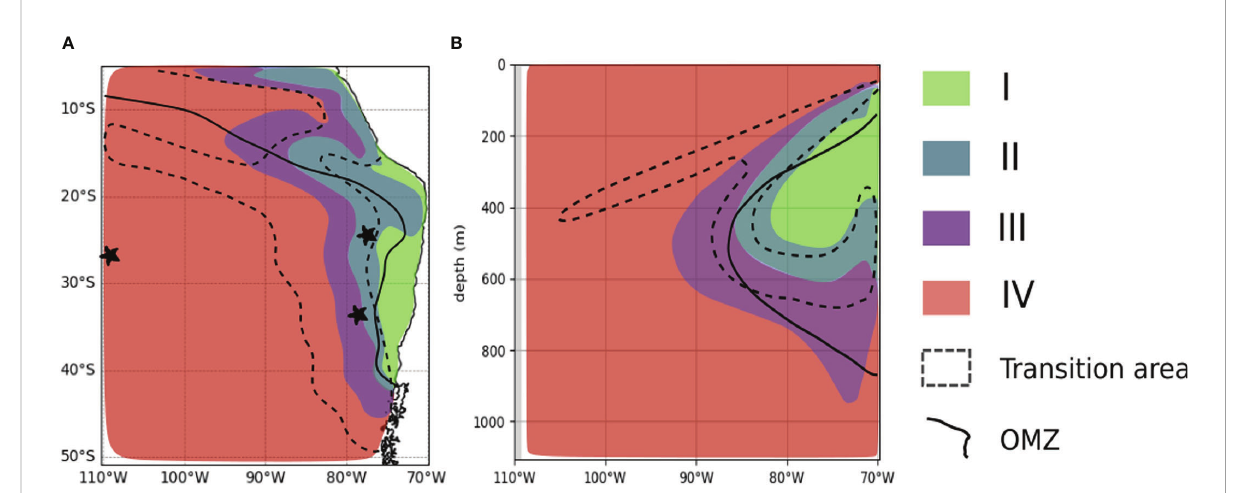
FIGURE 9 Areas of climate change exposure. Areas of climate exposure in the SEP at 200m (A) and the vertical representation at 26°S (B) derived from the horizontal velocities. We de fi ned areas of climate exposure based on the components of the climate velocities of Ф using the model species. Areas I and II designate “ safe ” areas based on positive trends in Ф . Areas III and IV designate “ at risk ” areas based on negative trends in Ф . Areas II and III are areas of slow velocities (|CV|< 1 km.yr -1 ) where the spatial gradient controls the magnitude of CV F over the temporal trends. The transition area (dashed envelope) is the area most subjected to uncertainty in the sign and magnitude of the velocity due to high uncertainty in the sign of oxygen trends and the effect of E 0 . The black and solid contour represents the OMZ limit at 45 mmol.m -3 . Note that the OMZ contour also coincides with F =